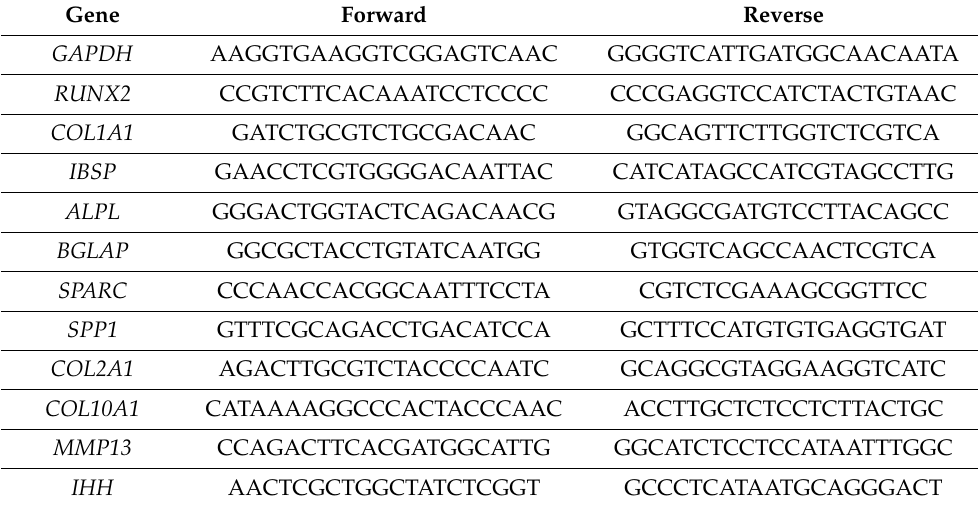
Table 1. Primers utilized in the RT-PCR